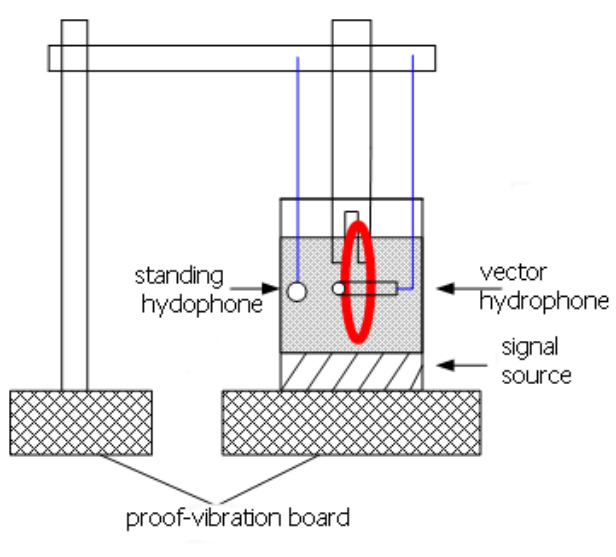
Figure 10. Principle chart of the calibration